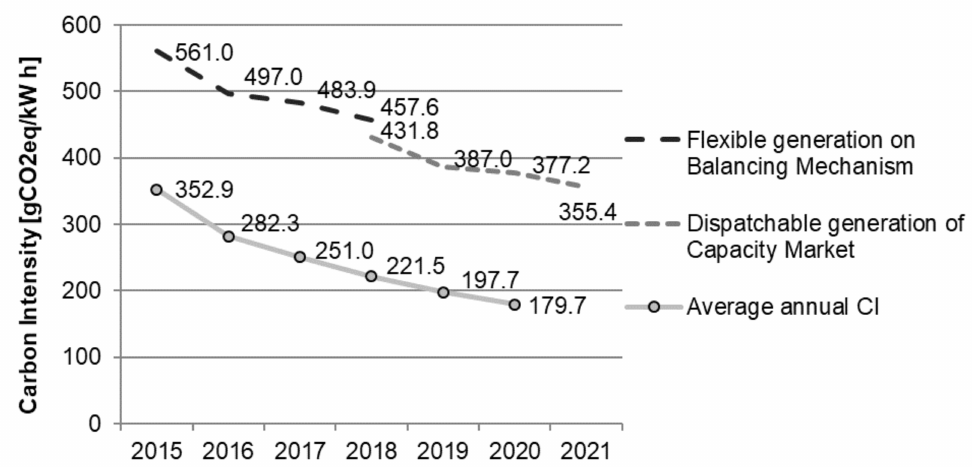
Figure A1. Carbon intensities of BM, CM and grid including scope-1 and